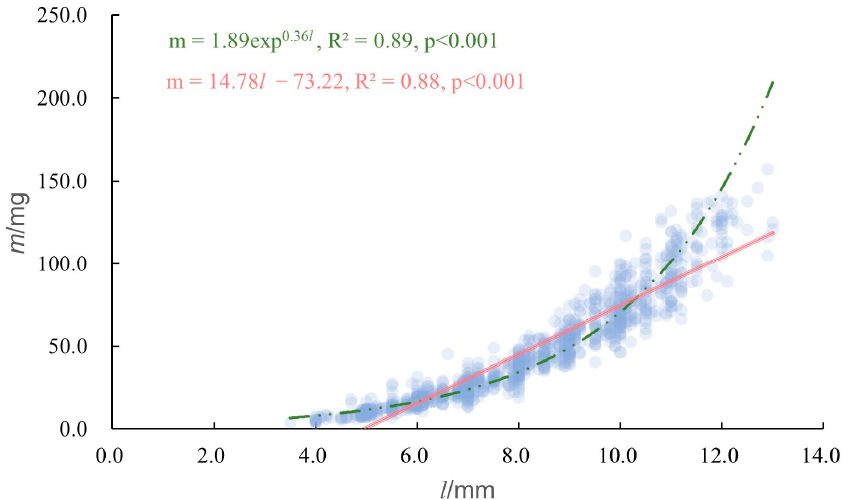
Figure 5. Regressions between body length and body weight of pill bugs .